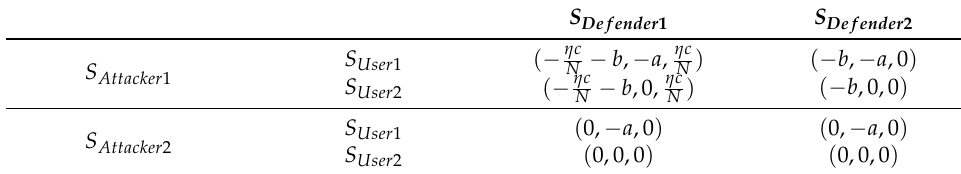
Table 3. Payoff matrix when providing honeypot